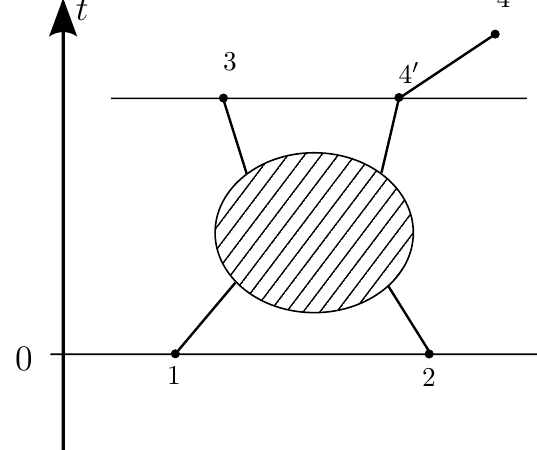
Figure 2 . Horizontal lines are t = t 3 and t = t 1 = t 2 = 0 . The coordinates of the point 4 0 are ( t 0 = t 3 , x 0 ) . x 0 is integrated from −∞ to + ∞ 4 4 4